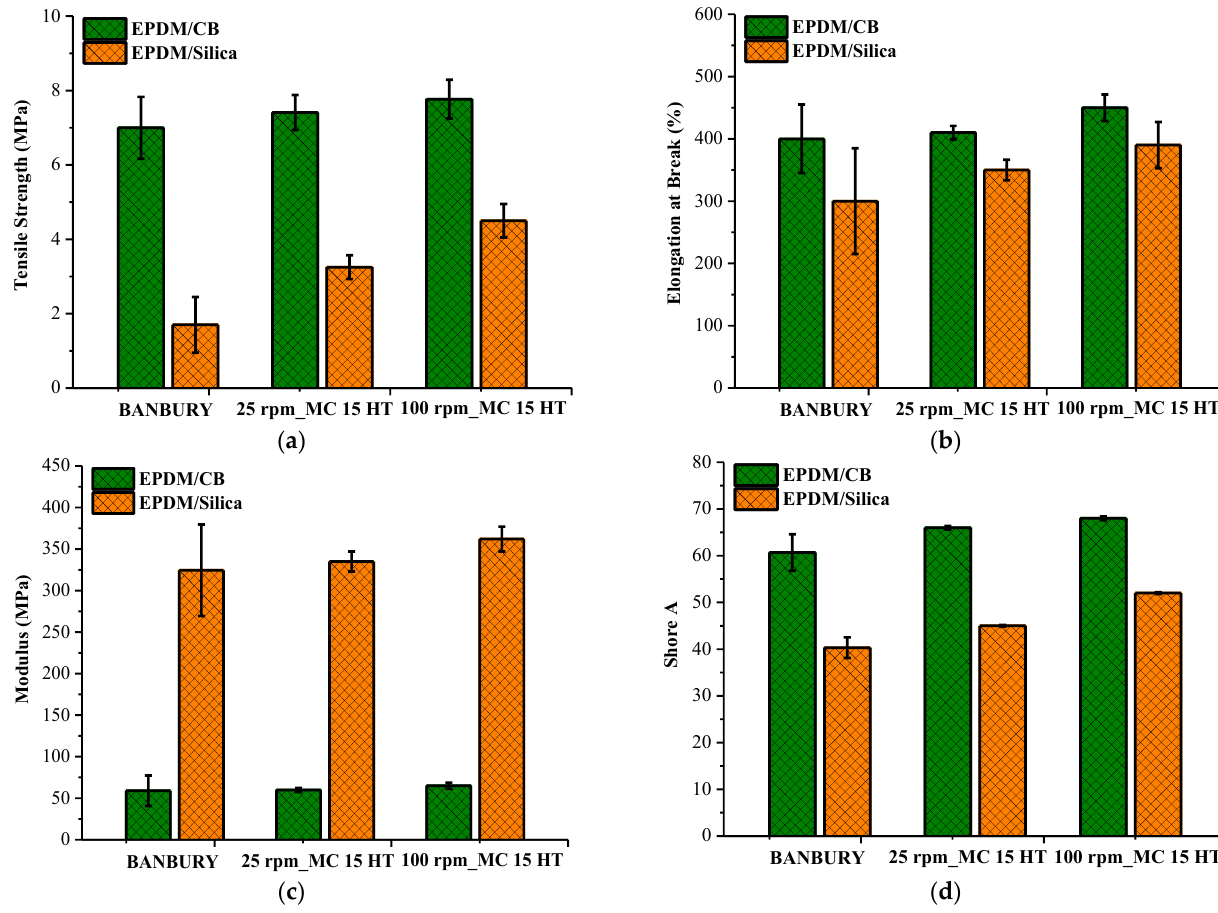
Figure 11. ( a ) Tensile strength values, ( b ) Elongation at break values, ( c ) Young’s modulus, ( d ) Shore A values of samples.